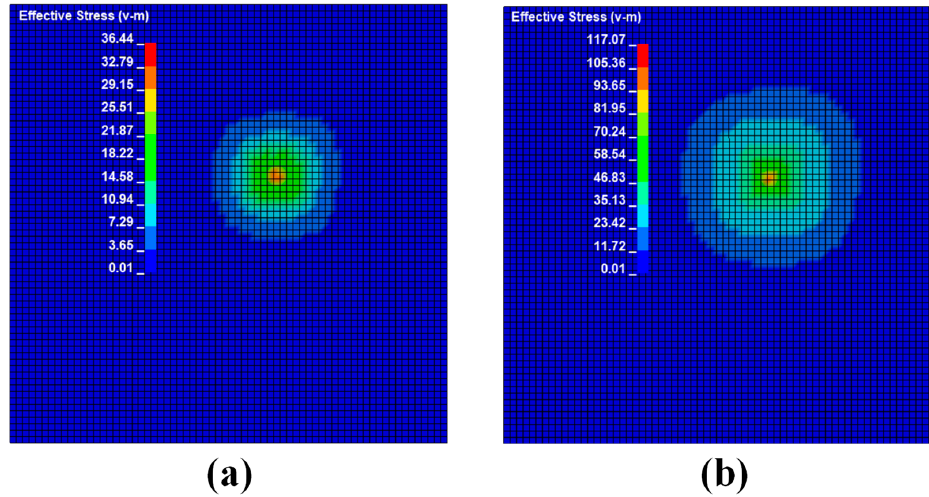
Figure 8. Stress curve of detection point at impact at position 1.